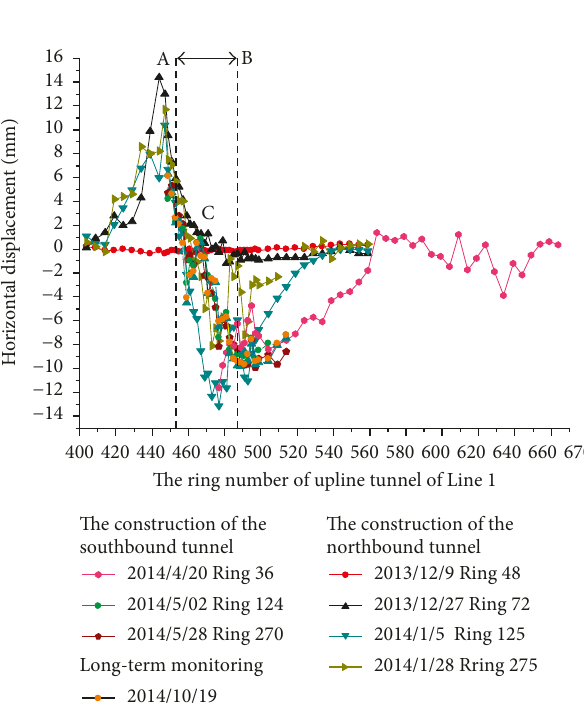
Figure 10: Time-varying horizontal displacement of the existing